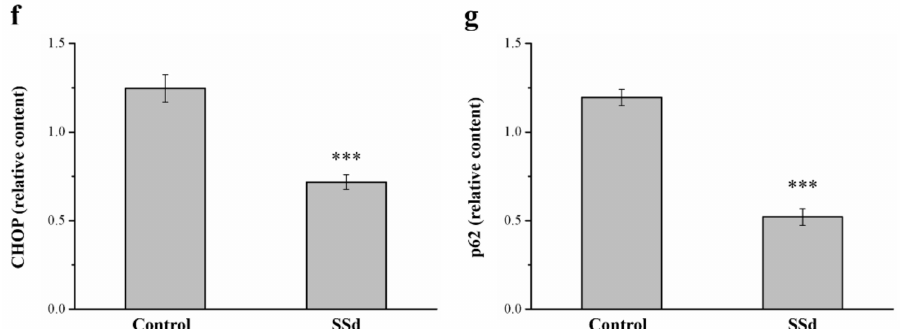
Figure 9. Effects of SSd treatment on ( a ) serum and ( b ) hepatic triglycerides. ( c ) Representative image showing blots of liver extracts. The expression of ( d ) p-eIF2 α /eIF2 α , ( e ) ATF4, ( f ) CHOP, and ( g ) p62 was measured. All data are reported as means ± SD (n = 8). * p < 0.05; ** p < 0.01; *** p < 0.001. p-eIF2 α , phosphorylated eukaryotic initiation factor 2 α subunit; ATF4, activating transcription factor 4; CHOP, C/EBP homologous